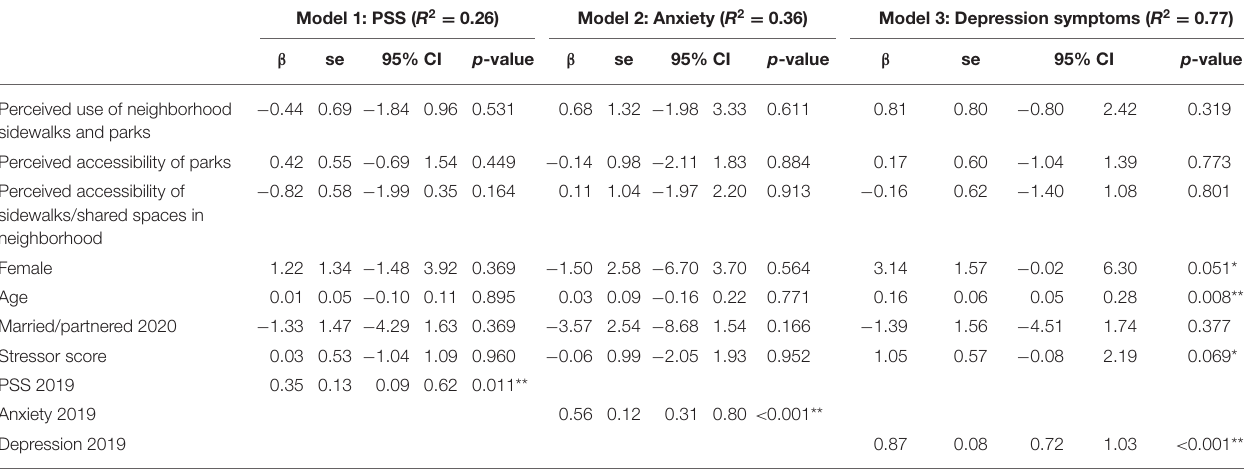
TABLE 3 | Regression modeling results predicting Perceived Stress Scores (PSS), anxiety, and depression symptoms in 2020, inclusion of perceptions of access to nature.